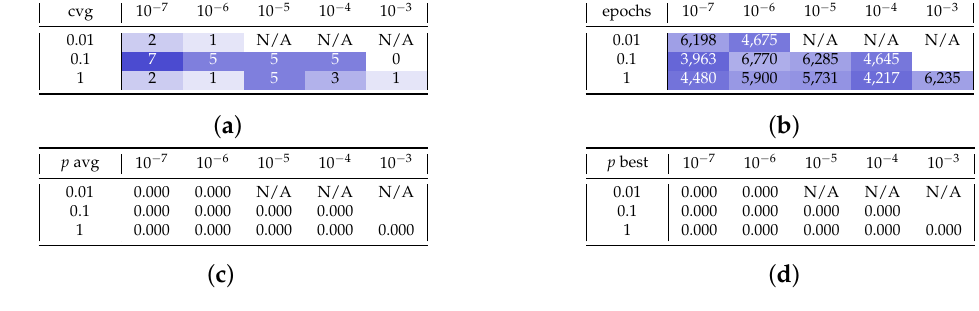
(a) Converging runs, out of 10. Experiments marked with N/A were excluded from the test set.